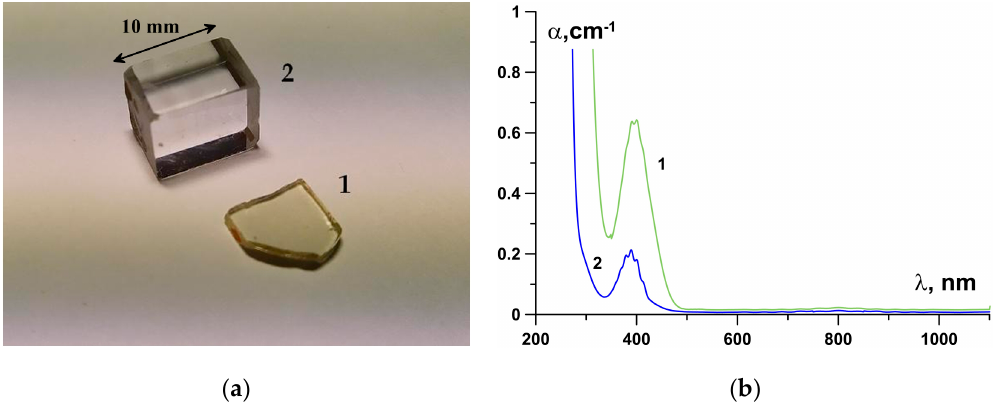
Figure 2. ( a ) Crystals appearance; ( b ) absorption coefficient: “1” is for “colored” crystal, “2” is for “clear” crystal. “clear”